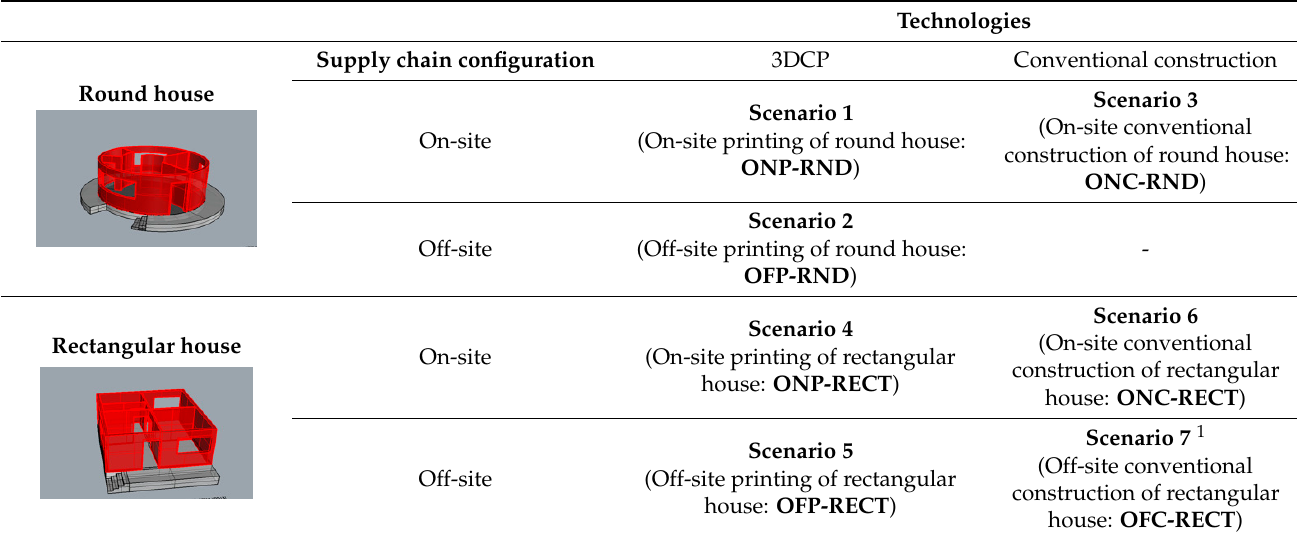
Table 1. Seven distinct scenarios for the research analysis and their designated names.